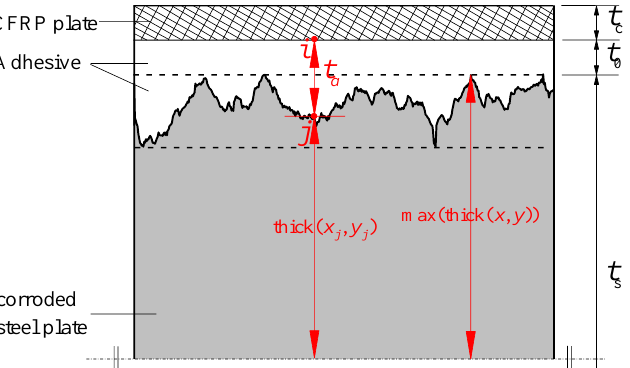
Figure 9. Diagrammatic sketch of the actual adhesive thickness corresponding to different positions on the surface of corroded steel plate.